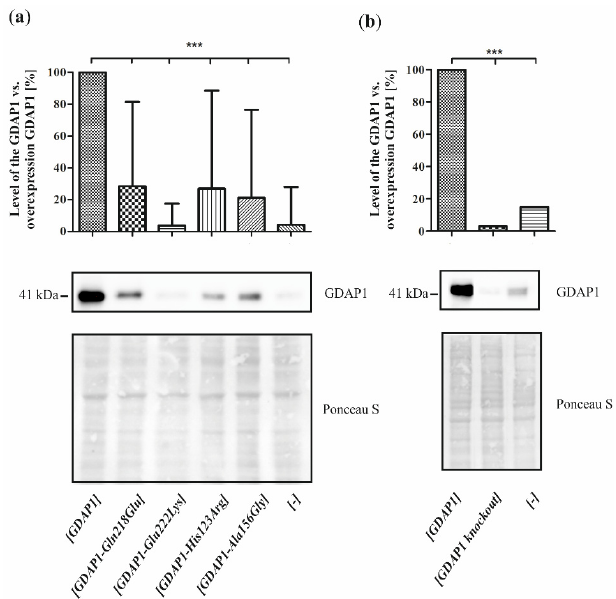
Figure 2. Different levels of GDAP1 protein in SH-SY5Y cells transfected with cDNAs of different GDAP1 variants. Western blot analysis of GDAP1 level in protein extracts from transfected SH- SY5Y cells with anti-GDAP1 antibody. Ponceau S staining of the blot shown as a loading control. Densitometric analysis of the GDAP1 protein level in SH-SY5Y cell line transfected to express indicated GDAP1 alleles. ( a ) the different variants of the GDAP1 gene; ( b ) the knockout of the GDAP1 gene. The relative level of GDAP1 mutant proteins to wild-type GDAP1 in SH-SY5Y cells. The results are means from three repetitions ± standard deviations; Statistical significance was determined using one-way ANOVA and Dunnett correction with *** p < 0.001 vs. GDAP1 overexpression SH-SY5Y